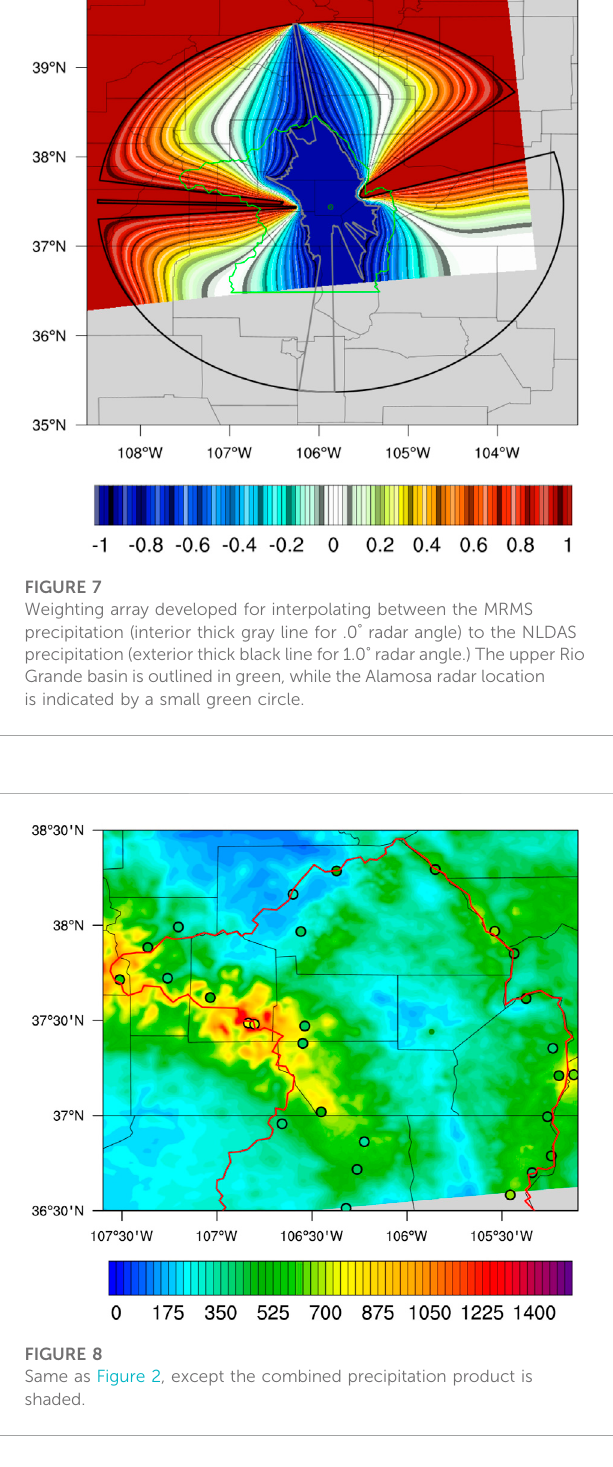
radar visibility at 1.0 ° , dark blue on Figure 6) and the MRMS product